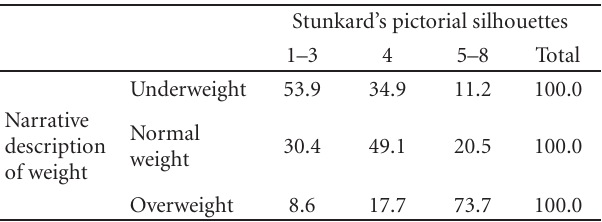
Table 2: Agreement between answers to the two questions on self- perceived weight.